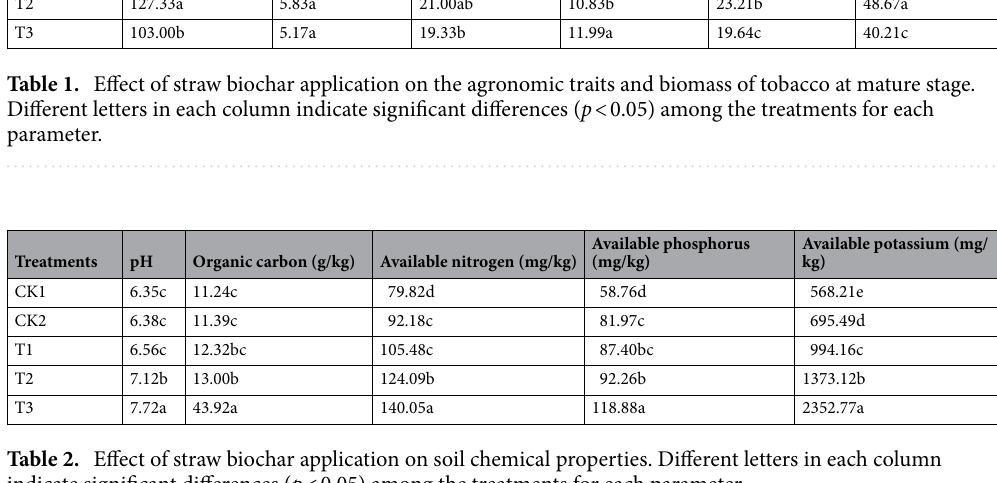
Table 2. Effect of straw biochar application on soil chemical properties. Different letters in each column indicate significant differences ( p < 0.05) among the treatments for each parameter.